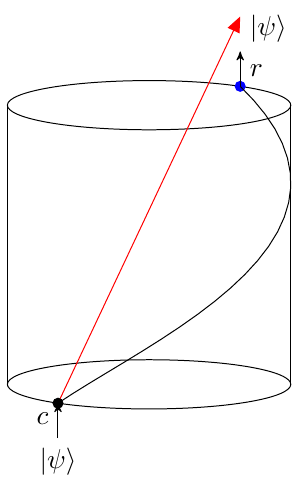
Figure 5. The quantum task discussed in section 3.1. A quantum state is received at a point on the boundary c and must be returned at the point r . Implication (3.1) implies that signals cannot travel faster through the bulk than through the boundary, consistent with the usual statement of boundary causality [27,